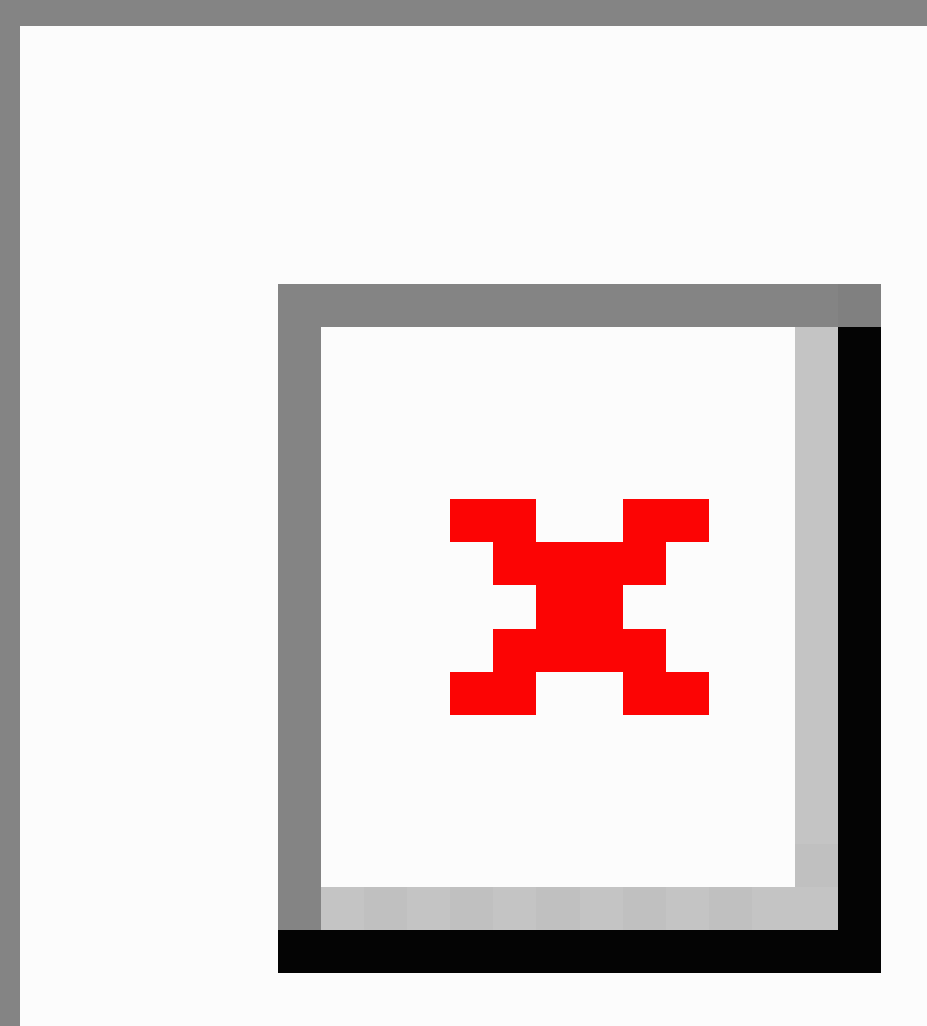
Figure 1. CONSORT Flowdiagram: Recruitment and retention of dental